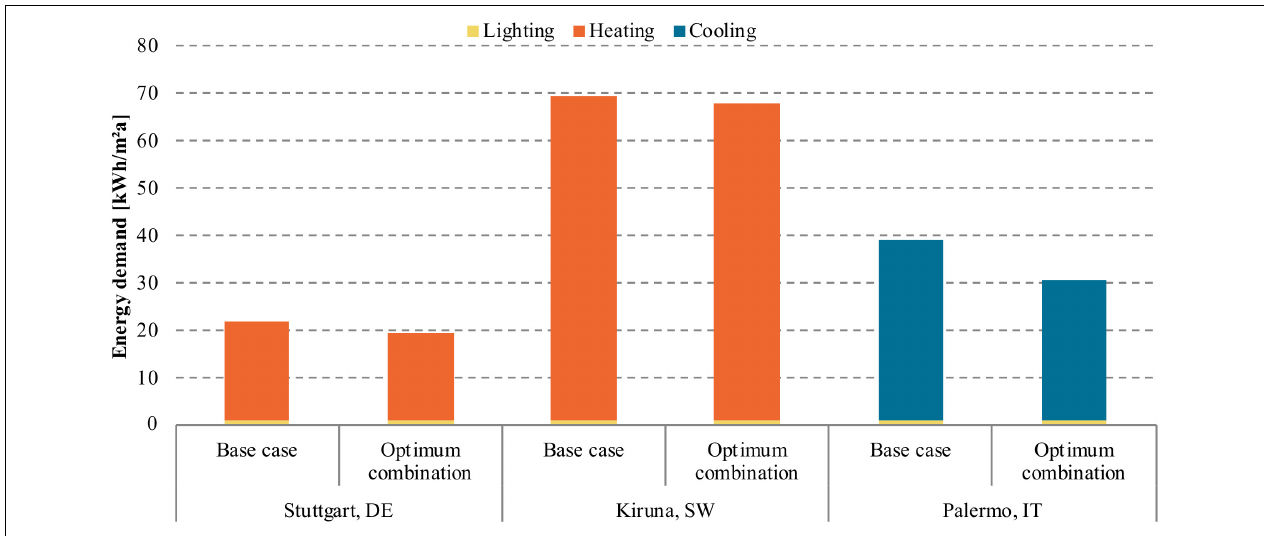
FIGURE 4 | Heating, cooling, and electricity for lighting demand for the combination of the best variations in comparison to the base case in the three assessed climate